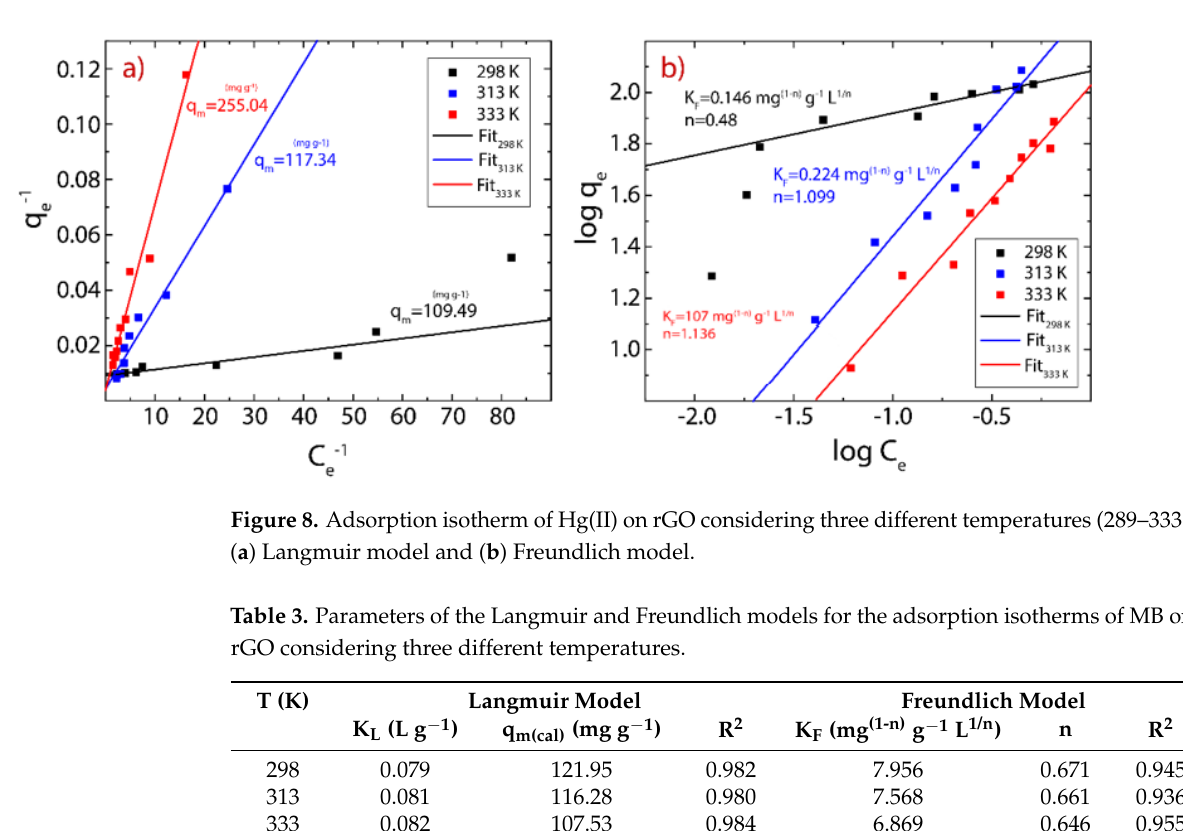
Figure 7. Adsorption isotherms of MB on rGO considering three different temperatures (289-333 K). ( a ) Langmuir model and ( b ) Freundlich model.